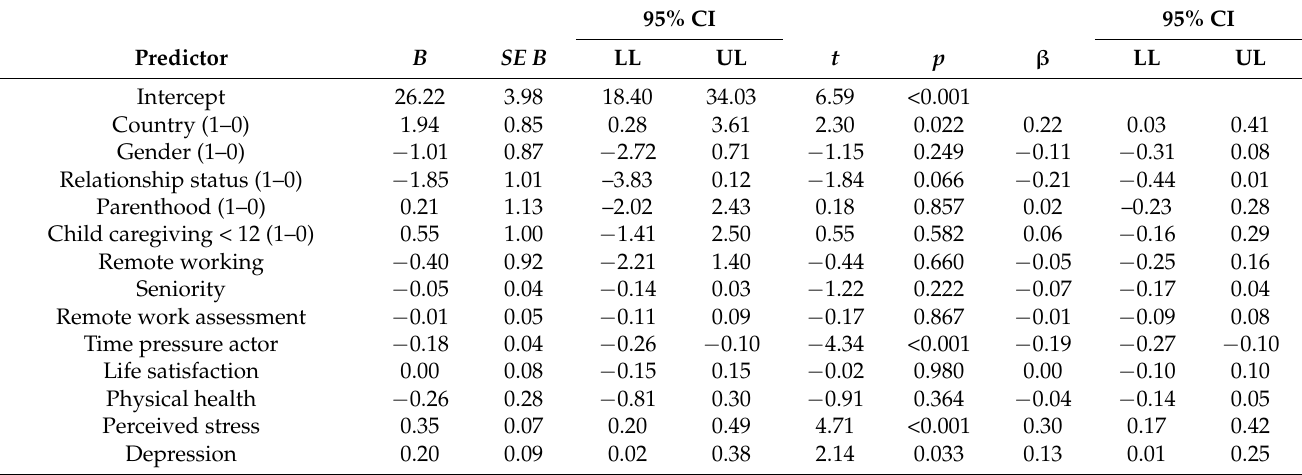
Table 2. Multiple linear regression for work-family conflict.